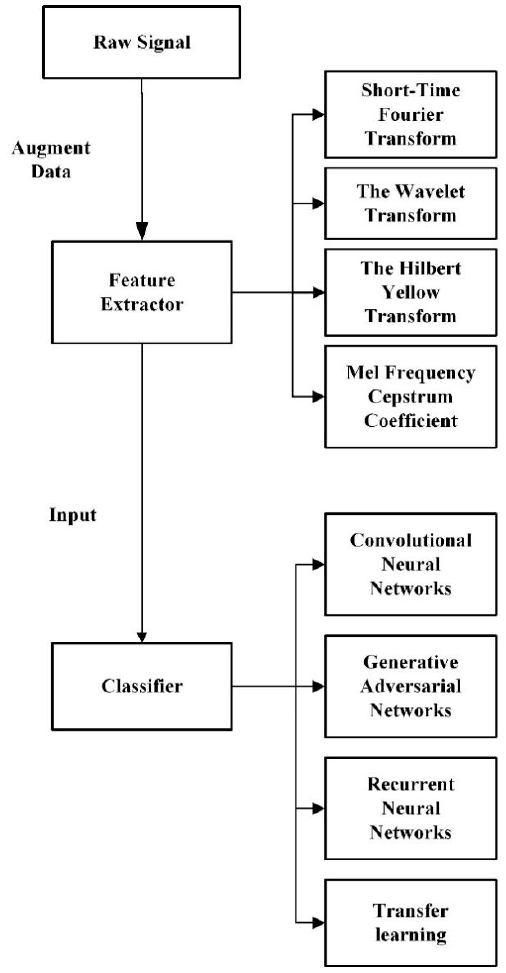
Figure 1. Classification process and method s .